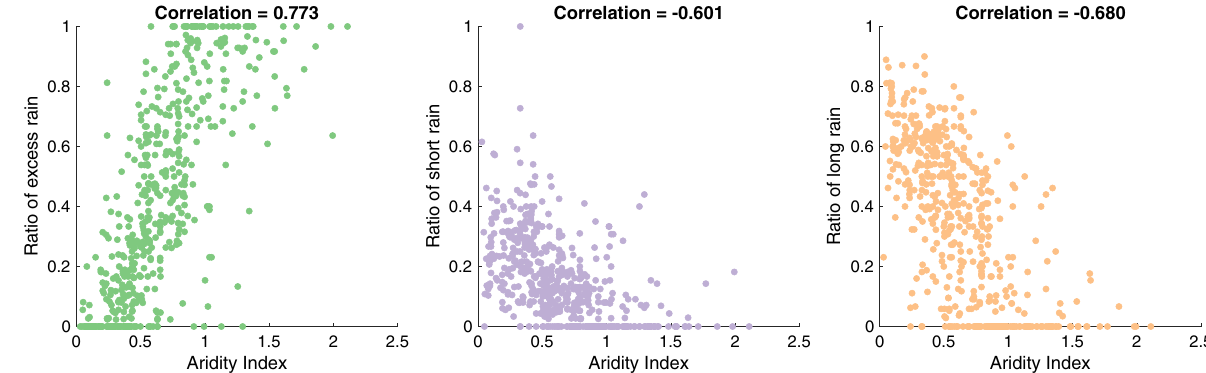
Figure 4. Scatterplots and Spearman correlations between the ratio of excess rain, short rain and long rains with the aridity index for the 529 catchments. All the results are significant at the 1% level. Aridity index is defined as AI = P/PET, so higher (lower) AI values correspond to a more (less) humid